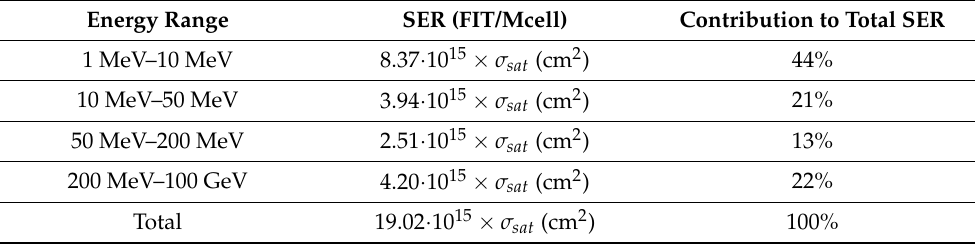
Table 1. Contribution of four main energy ranges to the SER in the framework of the worst-case analysis, i.e., with constant SEE cross sections for neutrons above 1 MeV. Calculations were made using the flux of the IEC standard divided by 300 to obtain the contributions at ground